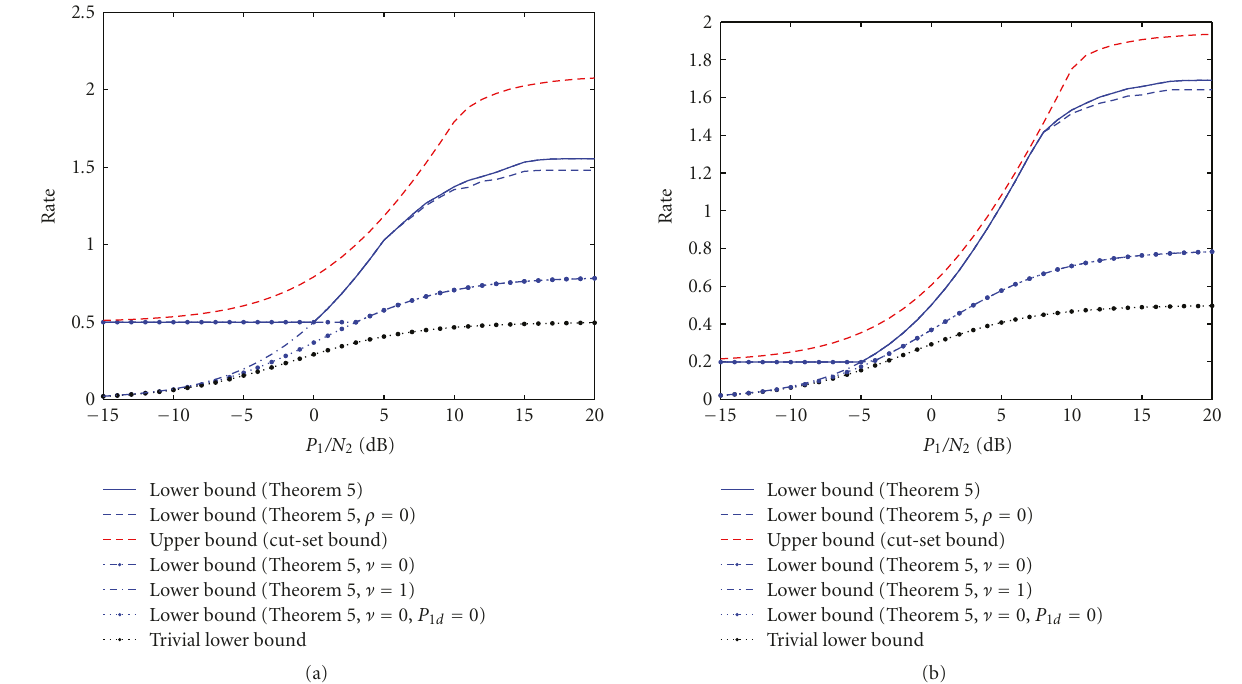
Figure 5: Illustration of the lower bound in Theorem 5 and some special cases of it. The bounds are plotted versus the SNR in the link source-to-relay. Numerical values are: (a) P 1 = 10 dB, P 2 = 20dB, Q = 10 dB, N 3 = 10dB and (b) P 1 = 5dB, P 2 = 20dB, Q = 5 dB, N 3 =